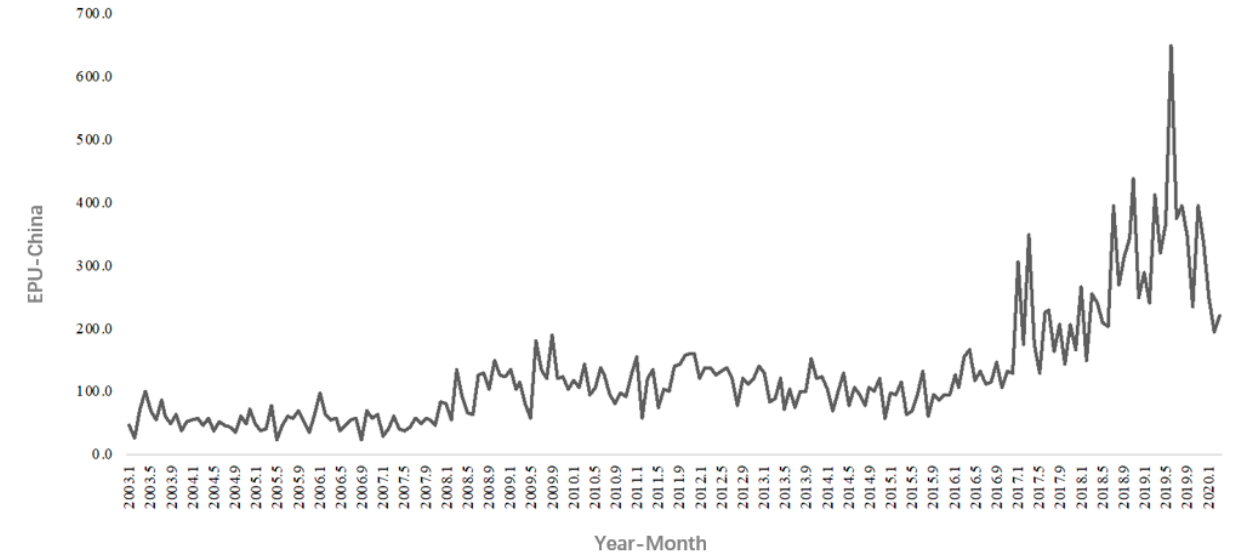
Figure 3. Monthly index of EPU in China from 2003 to 2020.